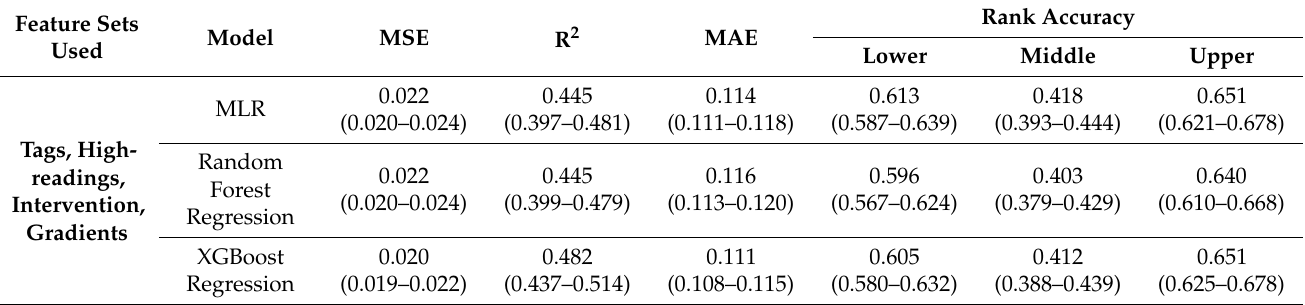
Table A8. Results of model trained on Using a filtered Dataset including only blood glucose levels [1, 31] (656 patients in training set, corresponding to 4580 windows; 163 patients in test set, corre- sponding to 1166